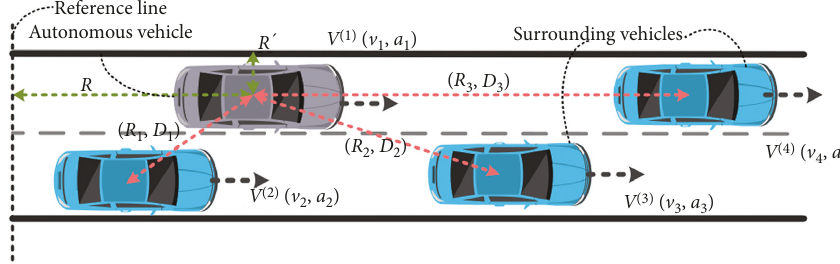
Figure 2: The description of the initial